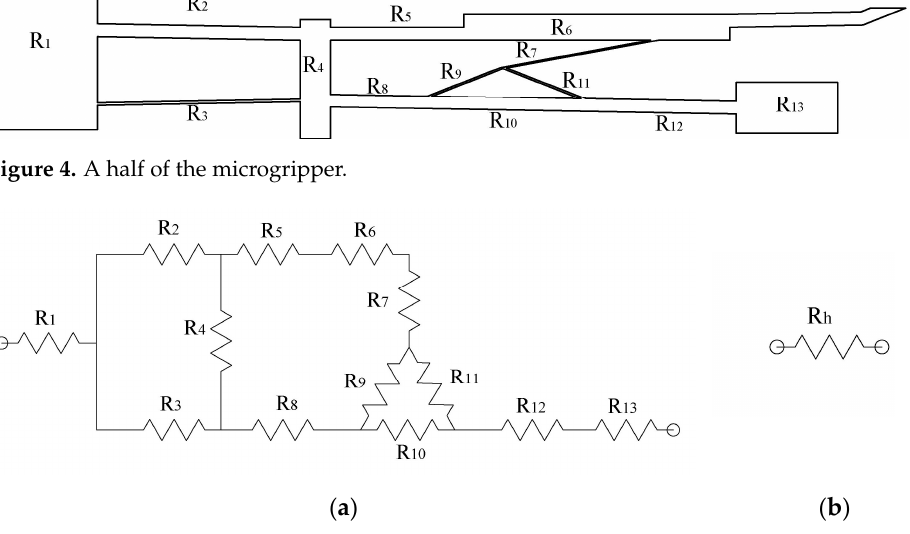
Figure 5. ( a ) Resistive equivalent circuit of one half of the microgripper with damping elements. ( b ) Equivalent resistance. Table 5. Geometric sizes of the elements with R 1 to R 13